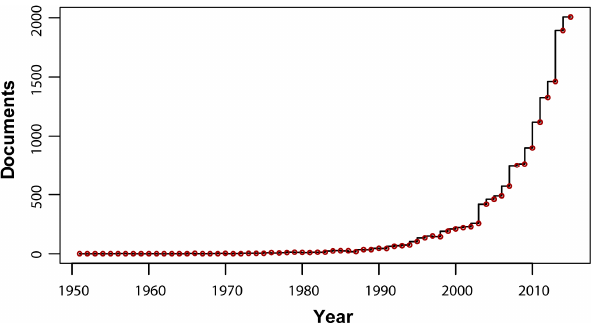
Figure 1. Number of publication documents (including original articles and reviews) from 1951 to 2016 that contain the keyword “linear mixed-effects model.” Literature search was conducted with Elsevier’s Scopus database [53].